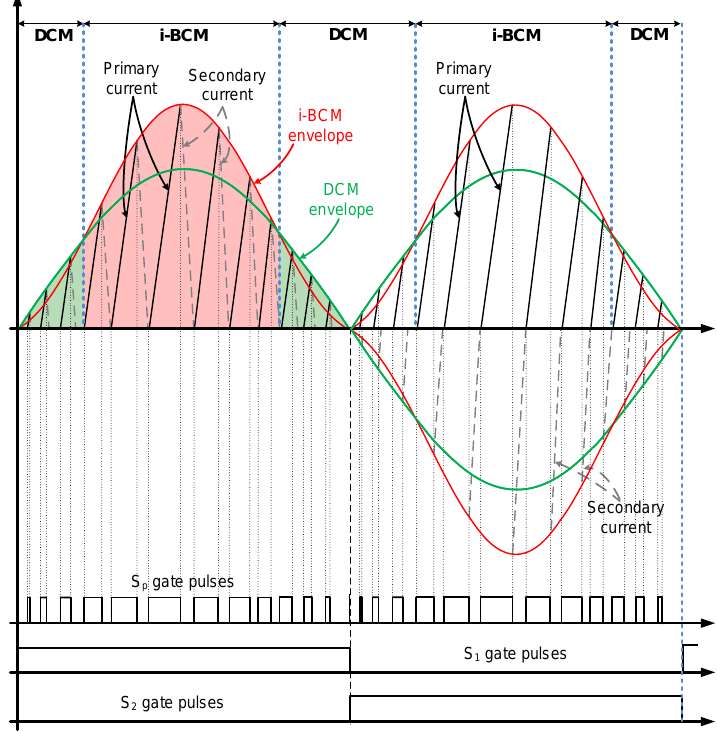
Figure 2. Primary and secondary winding currents and switching sequence for DBCM modulation.